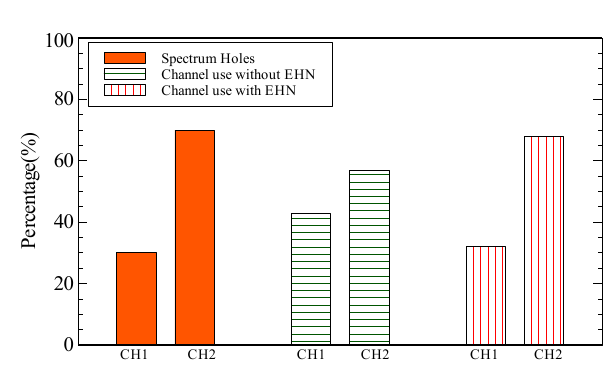
Figure 5. Percentage of spectrum opportunities on two PU channels and their opportunistic usage